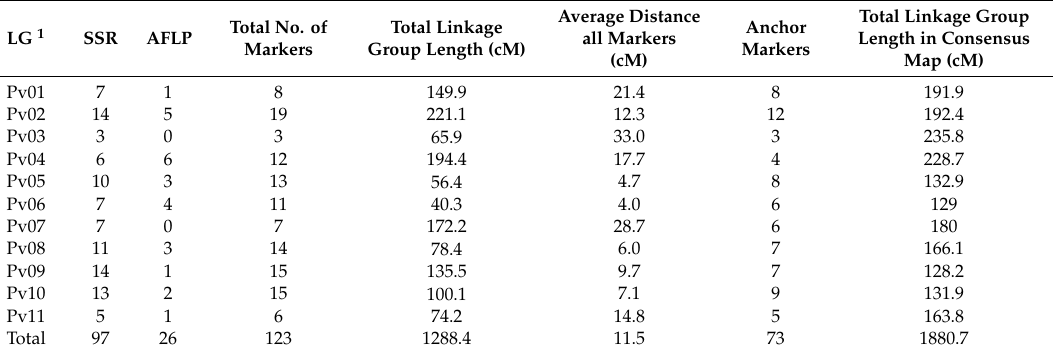
Table 1. Distribution of simple sequence repeat (SSR) and amplified fragment length polymorphism (AFLP) markers on the genetic map of common bean recombinant inbred line (RIL) population derived from the ‘Tiber’ × ‘Starozagorski’